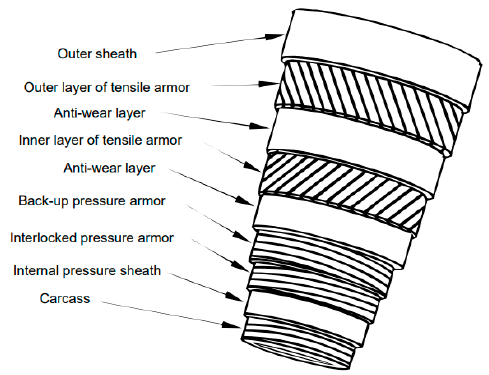
Figure 1. The several layers of a flexible marine riser. The outer sheath, antiwear layers, and internal pressure sheath are made from polymeric material, while the tensile armors, pressure armors, and carcass are constructed of steel [7].